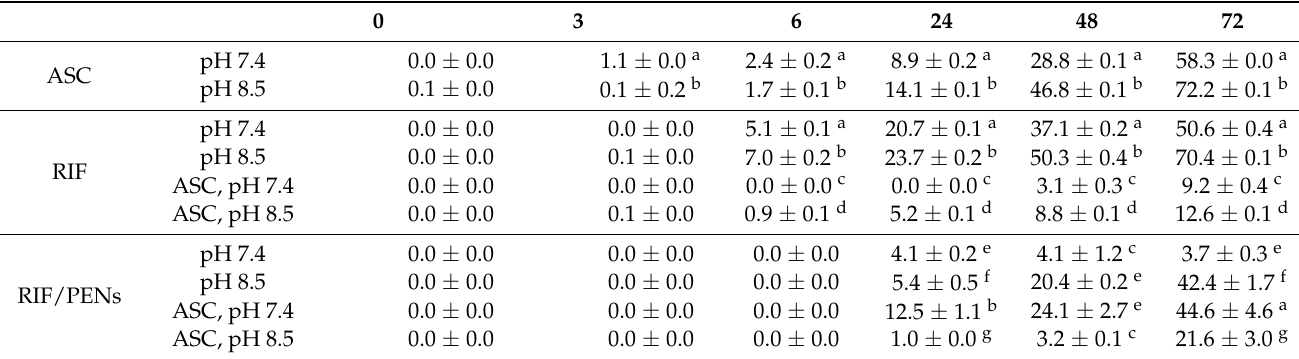
Table 4. Percentage of degradation in different environmental conditions and at predetermined time intervals